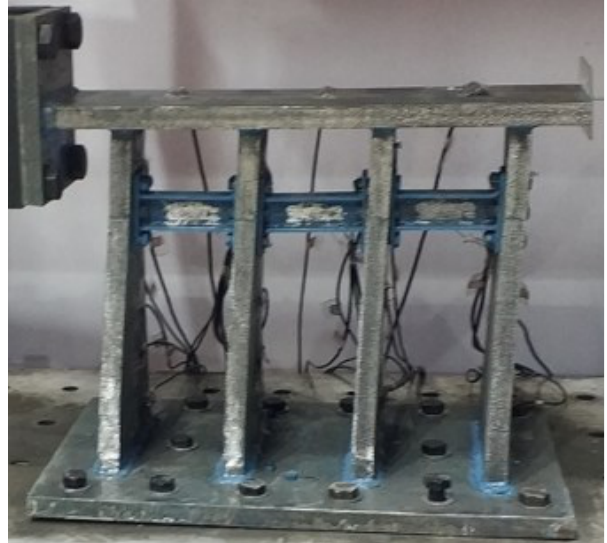
Figure 7. Deformation of the specimen during loading.